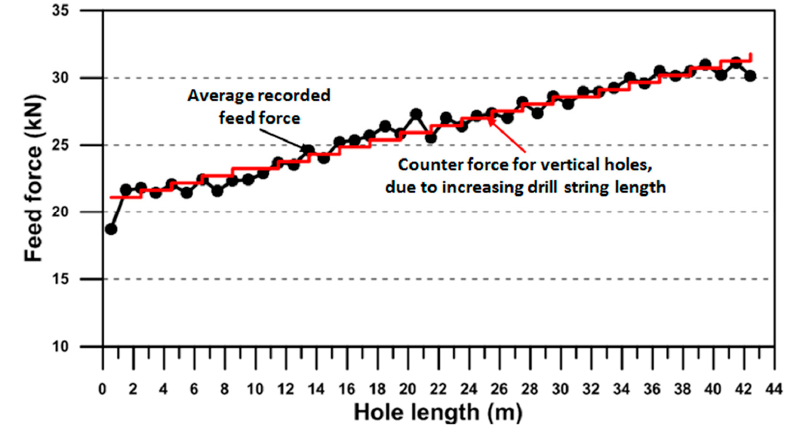
Figure 6. Feed force versus hole length.